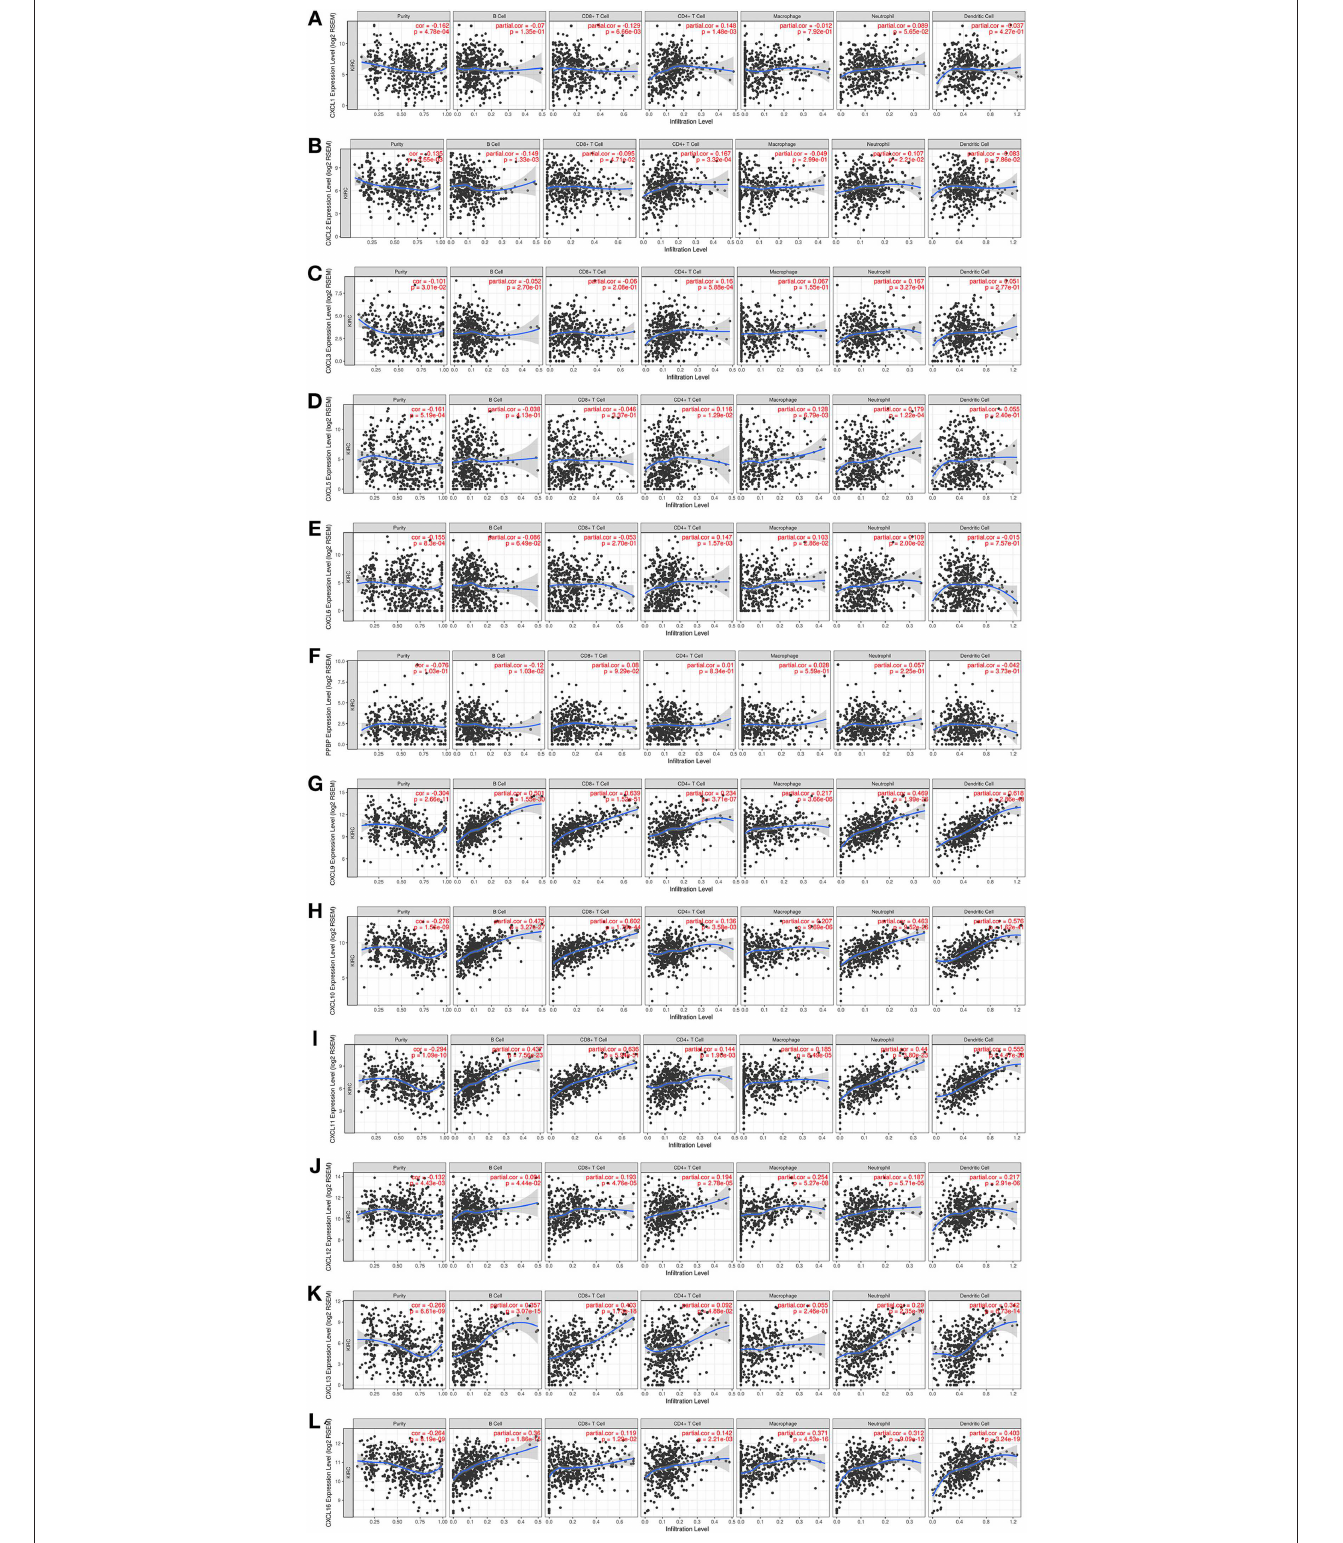
FIGURE 9 | The correlation between different expressed CXC chemokines and immune cell infiltration (TIMER). The correlation between the abundance of immune cell and the expression of (A) CXCL1, (B) CXCL2, (C) CXCL3, (D) CXCL5, (E) CXCL6, (F) CXCL7, (G) CXCL9, (H) CXCL10, (I) CXCL11, (J) CXCL12, (K) CXCL13, and (L) CXCL16 in